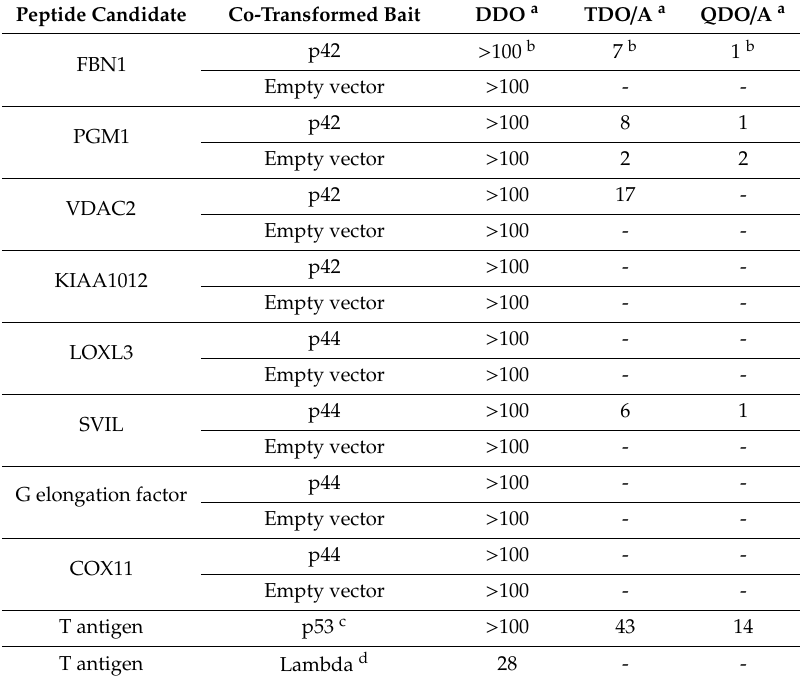
Table 2. Confirmation of the peptide candidates as binding partners for the full-length human OAS1 p42 and p44 isoforms using a yeast co-transformation